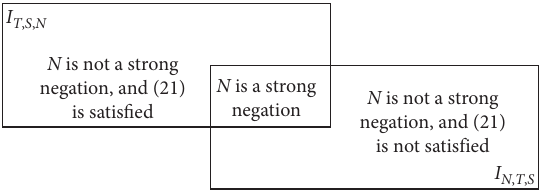
Figure 3: Intersection between families of QL - and QL ′ -operations (respectively,